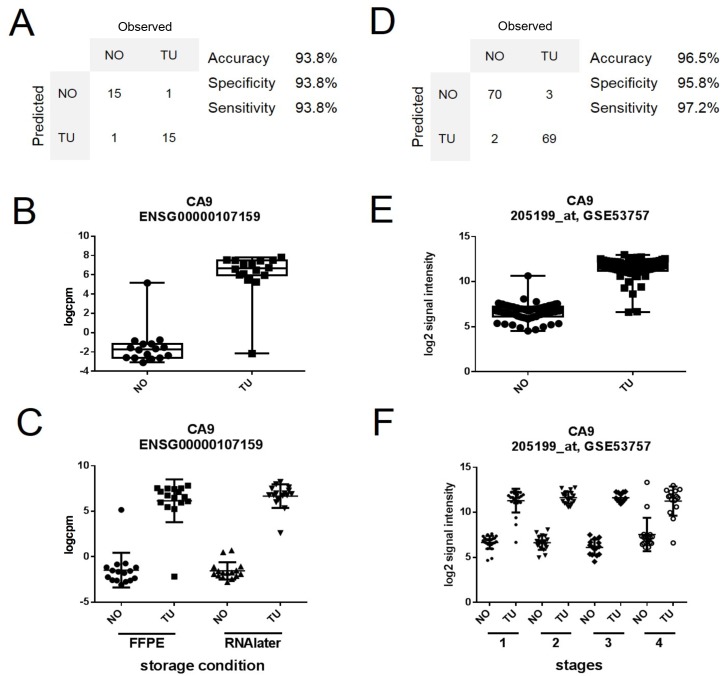
Development of a candidate marker for ccRCC.(A) Expression values of CA9 correctly classified 30 of 32 samples in our FFPE dataset. (B) Whisker plot of expression value distribution in our FFPE dataset for CA9. (C) Scatterplot for the expression values of CA9 in our FFPE and in our RNAlater dataset. (D) CA9 expression values correctly classify 139 out of 144 samples in a microarray dataset of ccRCC (GSE53757). (E) Distribution of CA9 expression values for normal (NO) and ccRCC tumor samples (TU) in the GSE53757 dataset. (F) Stratification of the expression values of overexpressed CA9 into all four stages of ccRCC [14].